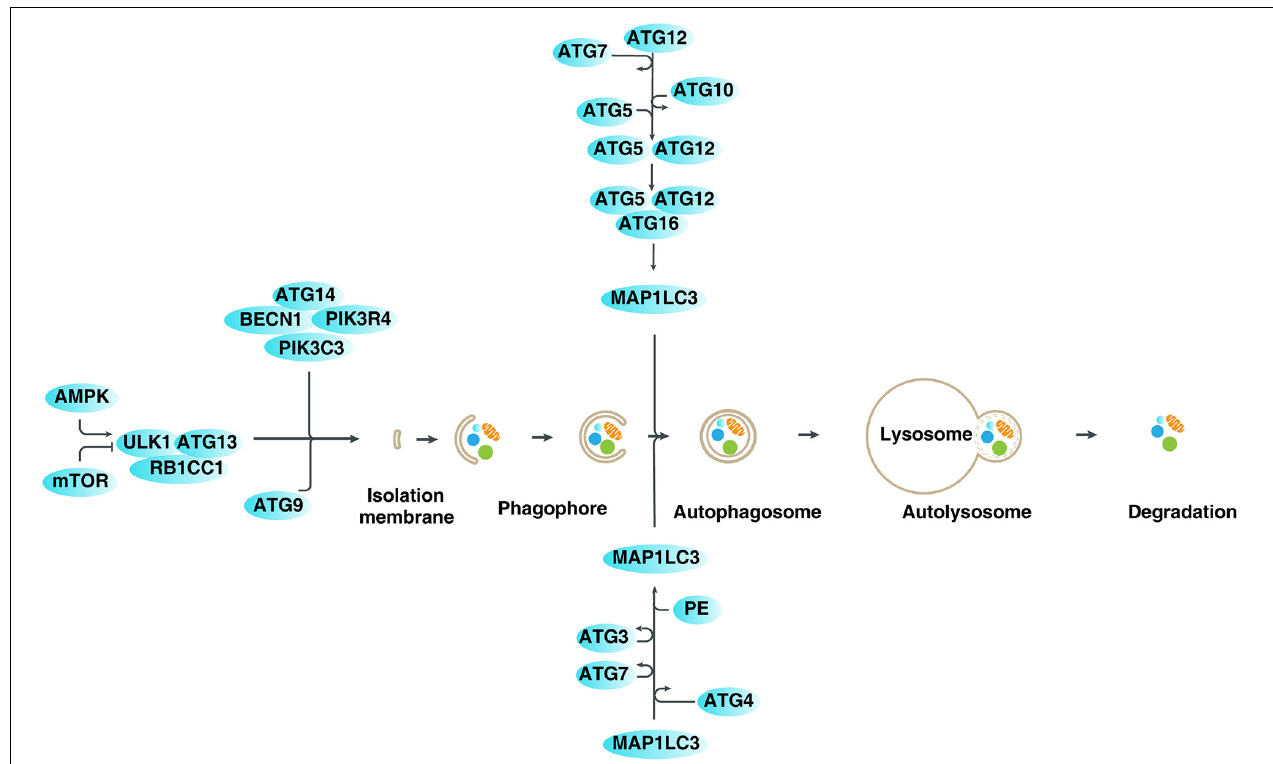
FIGURE 1 | Mechanisms and regulation of autophagy in mammalian cells. Autophagy is a dynamic process involving the formation of several specific membrane structures, such as phagophores, autophagosomes, and autolysosomes. ATG proteins, in association with various regulators, are involved in regulating the dynamic process of membrane structure formation, leading to the degradation of various cargoes in